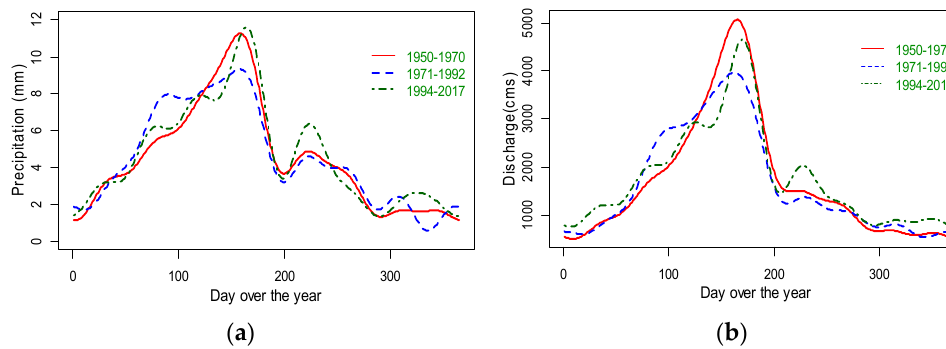
Figure 4. ( a ) Variation of areal precipitation above the drainage area above Zhuqi and ( b ) average daily discharge observed at Zhuqi during three different periods.